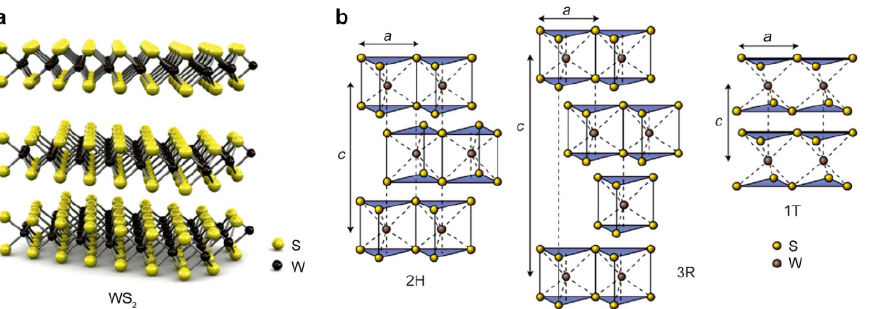
Figure 1. ( a ) General structure of WS2. Reproduced with permission.[30] Copyright 2011, Springer Nature. ( b ) The three identi ‐ fied polytypes structures of WS2: trigonal (1T), hexagonal